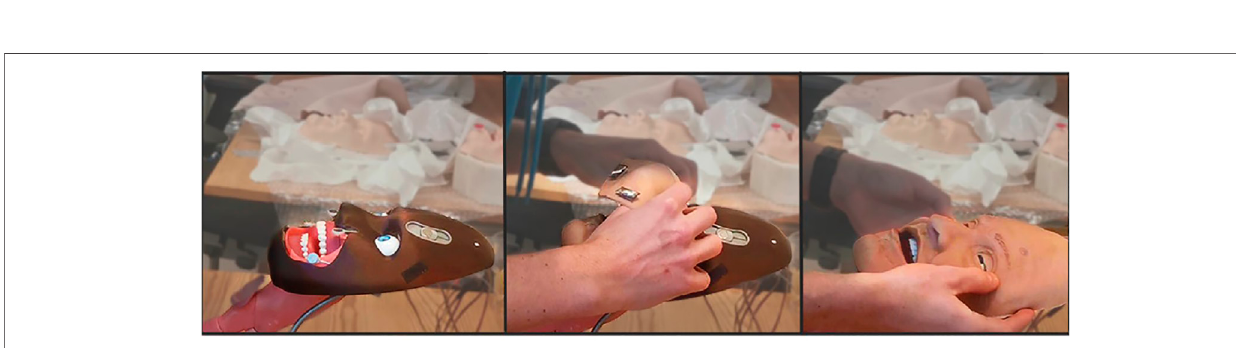
Frontiers in Robotics and AI |